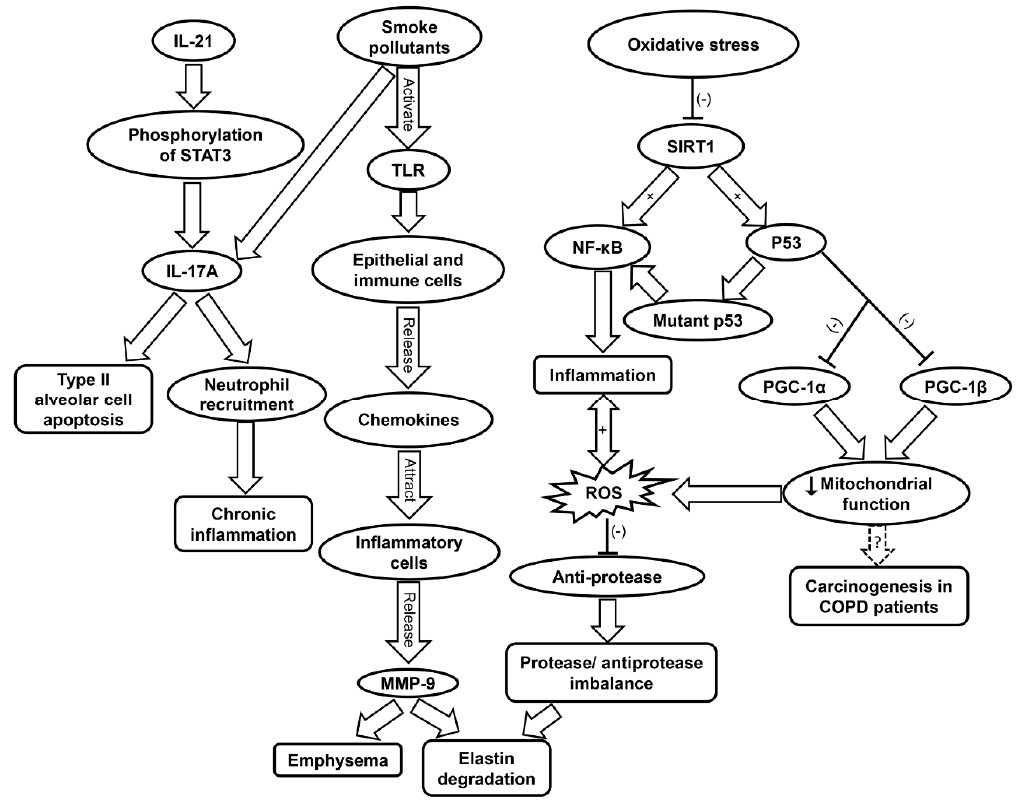
Figure 4. Schematic showing the molecular mechanisms contributing to COPD progression. COPD, chronic obstructive pulmonary disease; IL-17A, interleukin-17A; IL-21, interleukin-21; MMP9, matrix metalloprotease 9; NF- κ B, nuclear factor kappa-light-chain-enhancer of activated B; PGC, peroxisome proliferator-activated receptor- γ coactivator; ROS, reactive oxygen species; SIRT1, sirtuin-1; STAT3, signal transducers and activators of transcription 3; TLR, toll-like receptor.